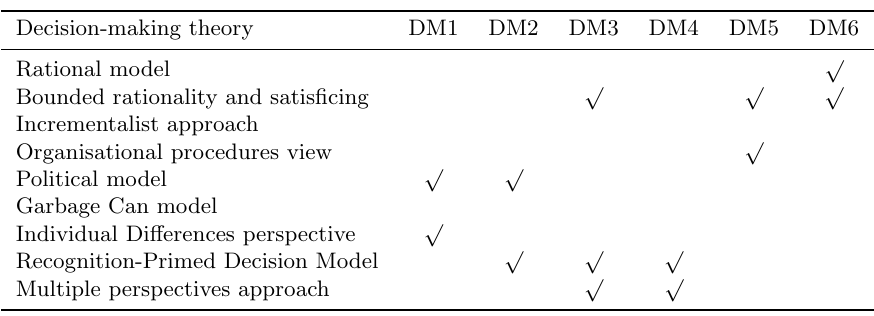
Table 1: Evidence of use of decision-making